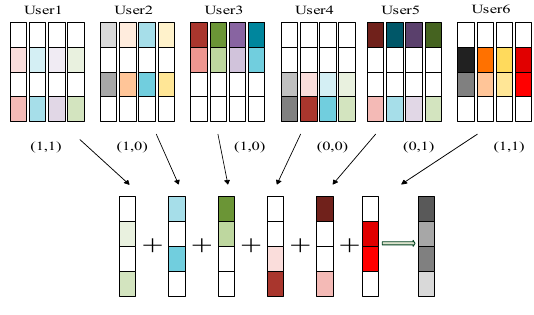
Figure 3. SCMA coding principle.